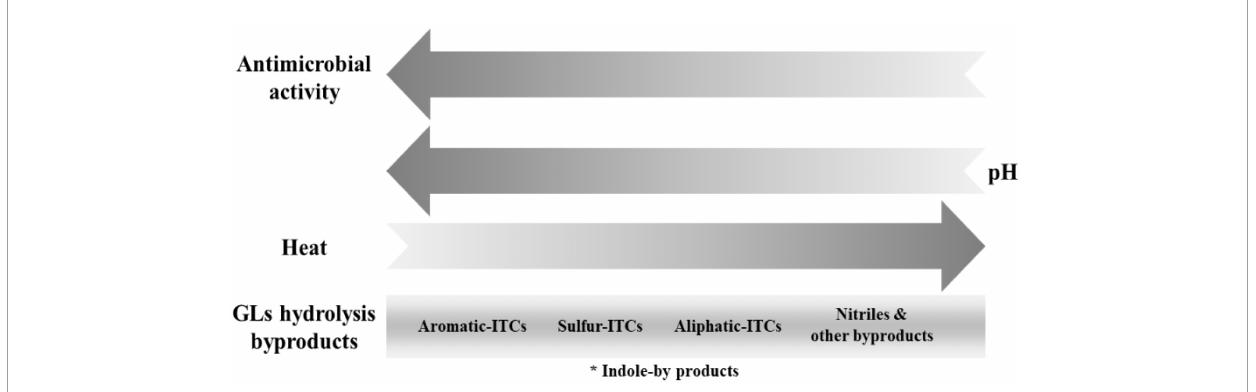
SCHEME6 Trend of the antimicrobial activity of glucosinolates hydrolysis byproducts as a function of the pH, temperature, and chemical structure. Hydrolysis byproducts include: isothiocyanates (ITCs), nitrile or amine-derivatives of glucosinolates. *Note that the position of indole isothiocyanate byproducts in this chart may vary, as they are unstable and can spontaneously decompose to other compounds such as indole-3-carbinol, indole-acetonitrile, thiocyanate ions, and 3,3-diindolylmethane. It should be noted that the susceptibility or activity of the glucosinolates hydrolysis products may vary depending on different factors and more comparative studies are needed to have a clear scheme. Arrows point to increasing